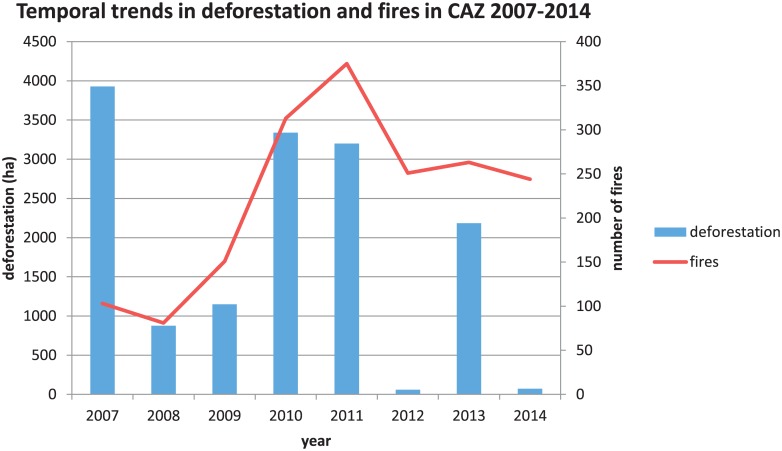
Temporal trends in deforestation and fires in CAZ 2007–2014.Annual deforestation rates (ha/year) are represented by blue bars and the number of fire detections are represented by the red line.